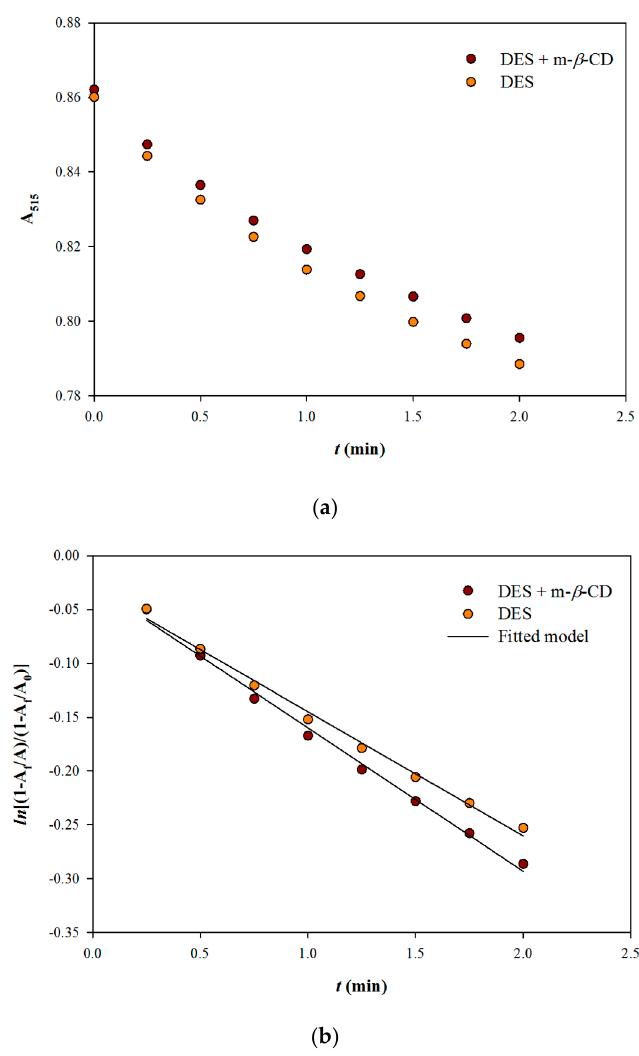
Figure 1 . Fast reaction kinetics recorded upon mixing OLL extract with DPPH. C TP was adjusted to 0.1 g L − 1 , c 0 was 100 μ mol L − 1 . ( a ) Time course of A 515 decrease within the first two minutes, ( b ) Second-order kinetics.